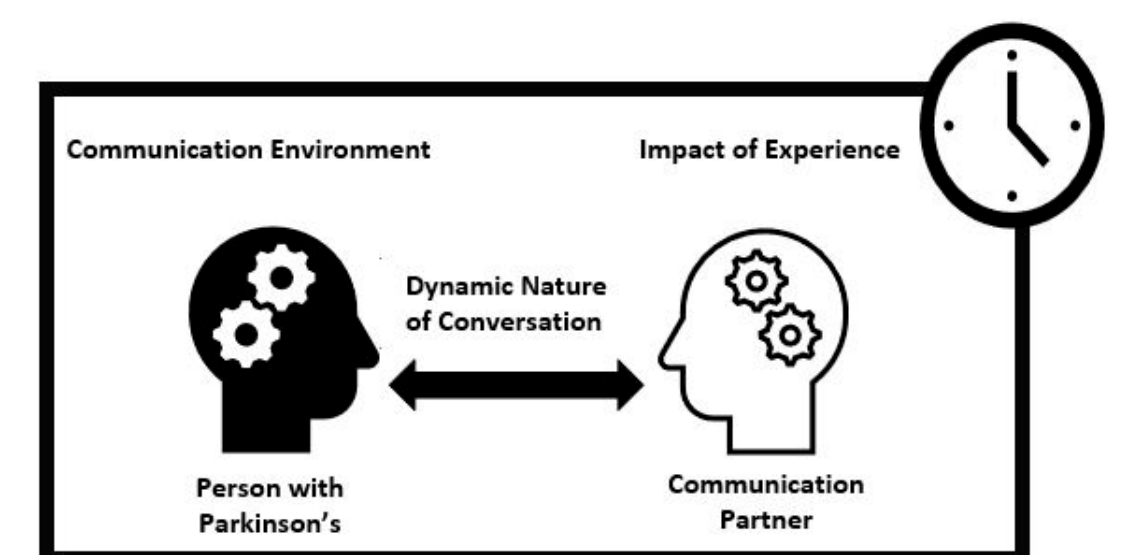
Figure 1. Conceptual diagram. Influences on conversation.